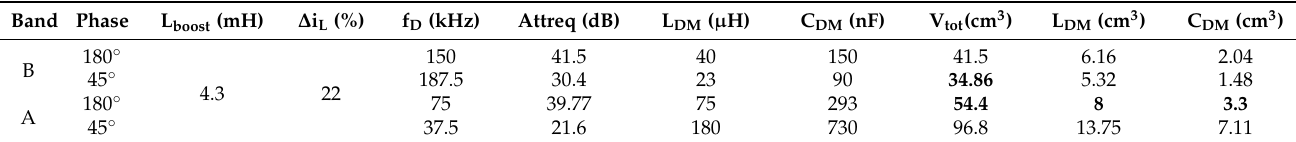
Table 4. Band-B and A EMI Filter Design Based on PLECS Simulations for conventional (180 ◦ ) and unconventional Phase Shift (45 ◦ ) regarding (17) And (18). The Switching Frequency is 37.5 kHz For Two Interleaved Units.